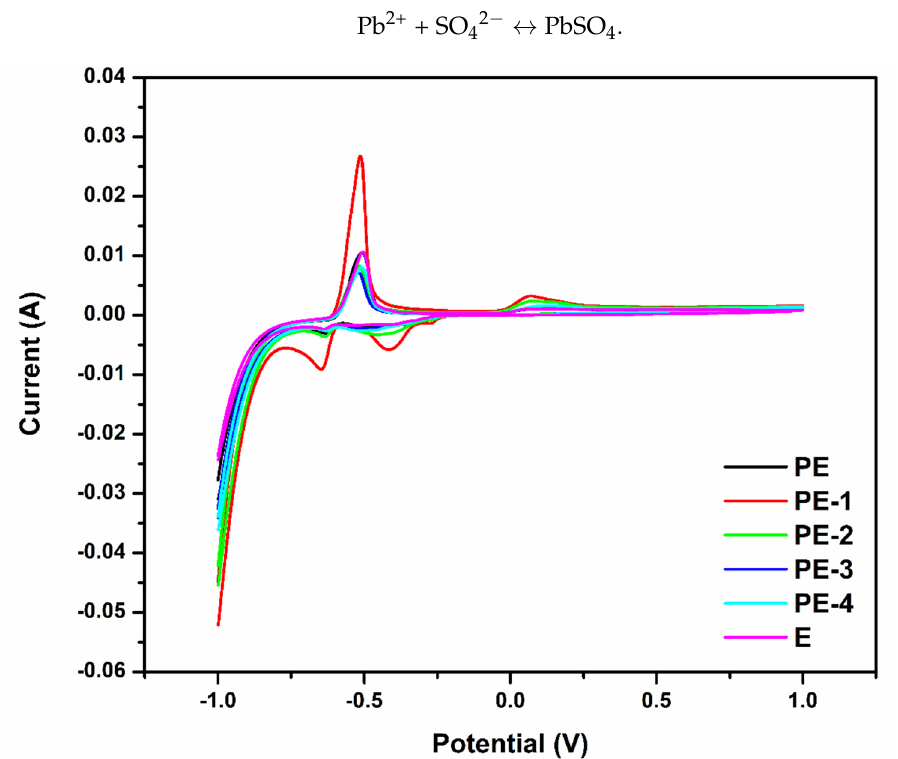
Figure 1. FTIR spectra of plane PVA (PE), PVA − 20 wt% TEOS (PE − 1), PVA − 40 wt% TEOS (PE − 2),